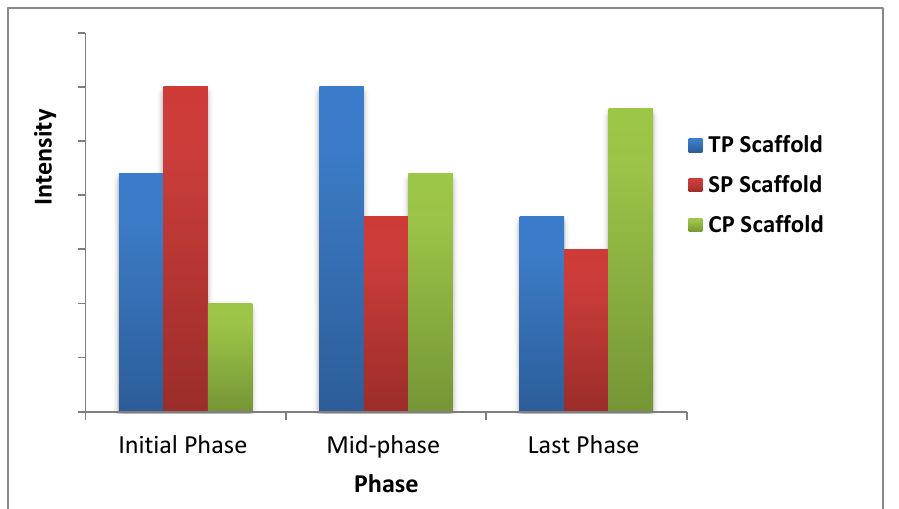
Figure 1. Scaffold intensity design in different phases of a course (adapted from Salmon,